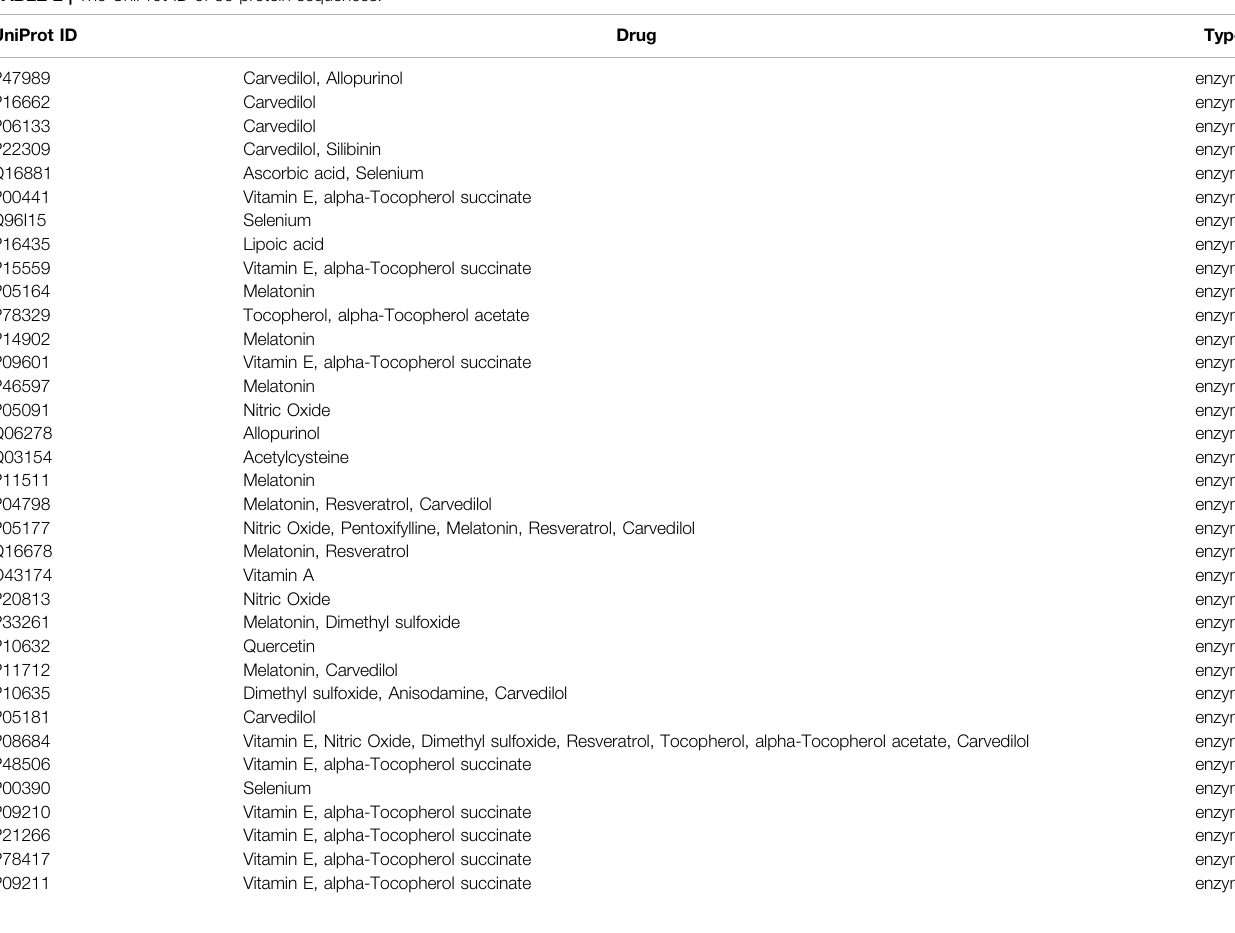
TABLE 2 | The UniProt ID of 36 protein